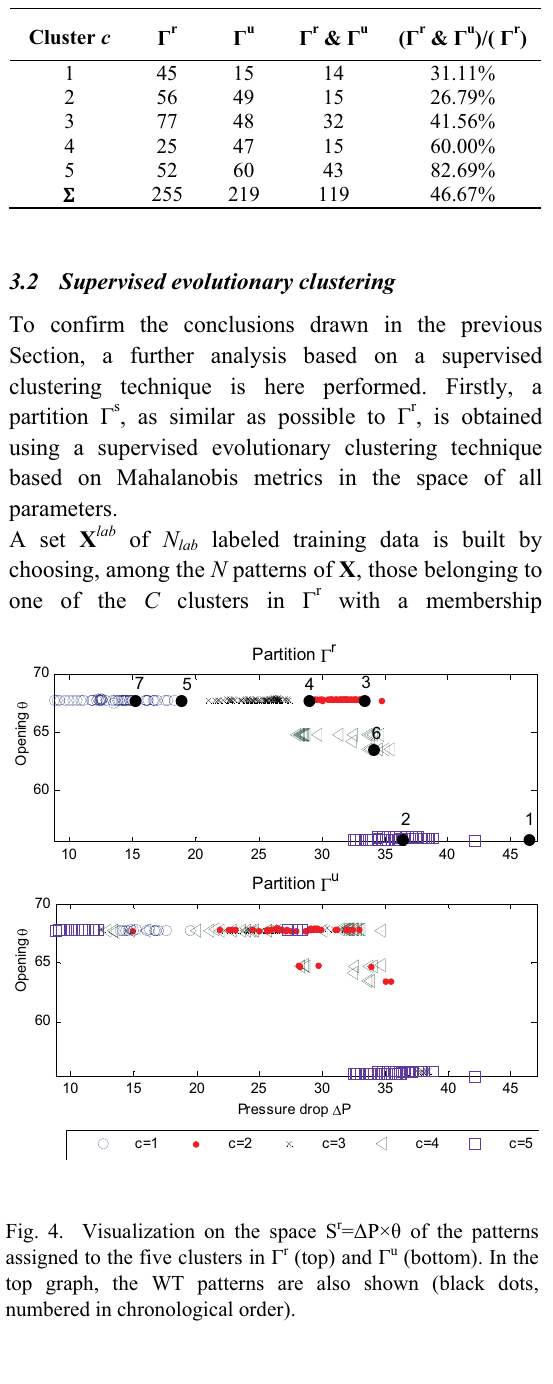
Table 2. Number of patterns assigned to each cluster in (cid:299) r (2nd column), in (cid:299) u (3rd column), in both (cid:299) r and (cid:299) u (4th column) and percentage of patterns assigned to the same cluster in both partitions with respect to the number of patterns assigned to that cluster in (cid:299) r